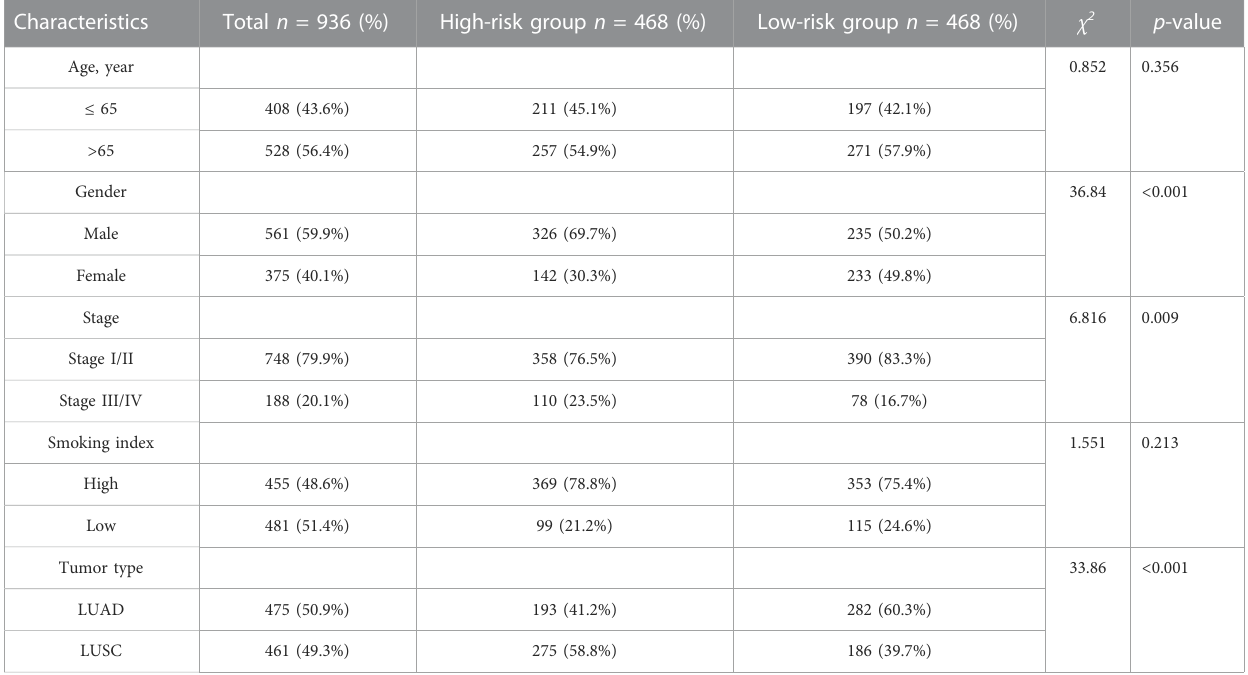
TABLE 2 Relationship between risk score and clinical characteristics of 936 patients in TCGA cohort.